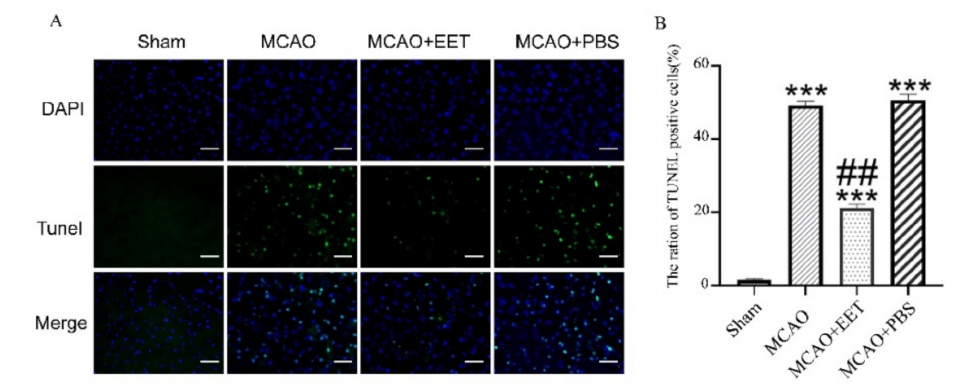
Figure 2. Neuronal apoptosis was detected by Tunel method after MCAO and reperfusion. ( A ) Tunel was used to detect cell death at 22 h after middle cerebral artery occlusion and reperfusion in mice.